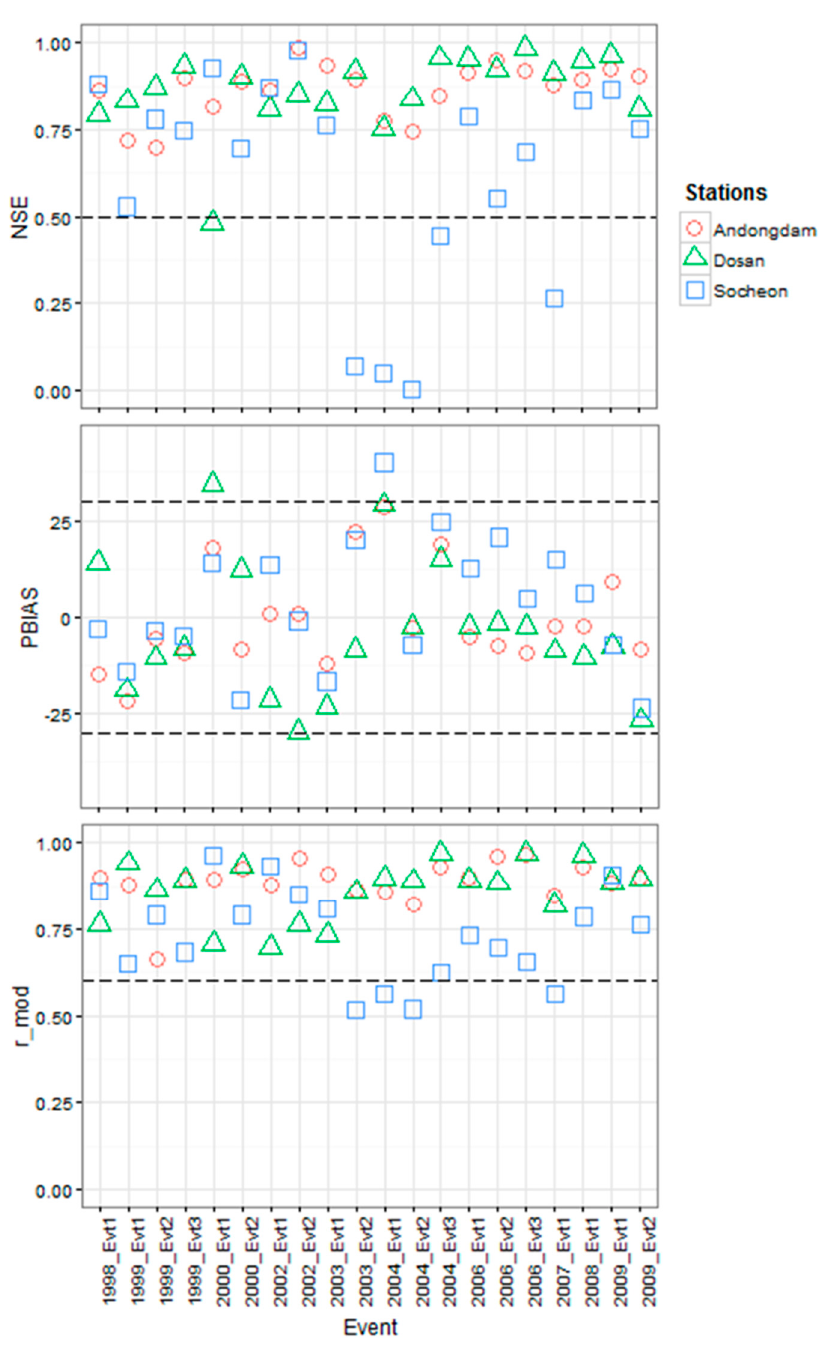
Figure 5. Model performance evaluation statistics of the Nash–Sutcliffe efficiency (NSE), percent bias (PBIAS), and r mod (r_mod) for the calibration (Andongdam) and validation (Dosan and Socheon) catchments for 20 events. The black dashed lines represent the acceptance boundaries of the performance evaluation statistics: NSE > 0.5, PBIAS ± 30%, and r mod > 0.6.